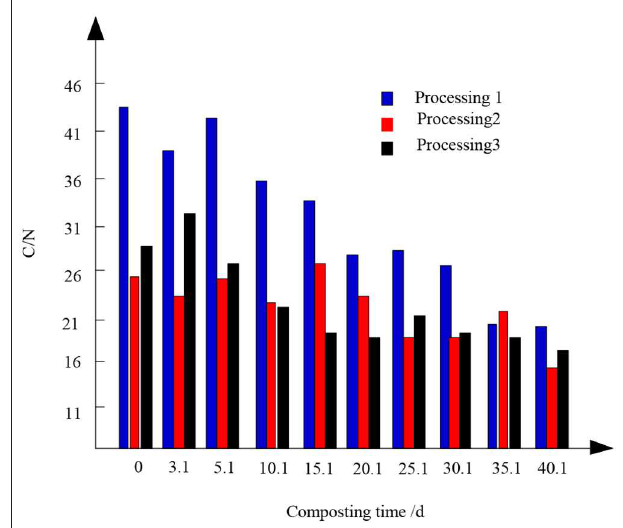
FIGURE 2 | The change of C/N ratio in different composting